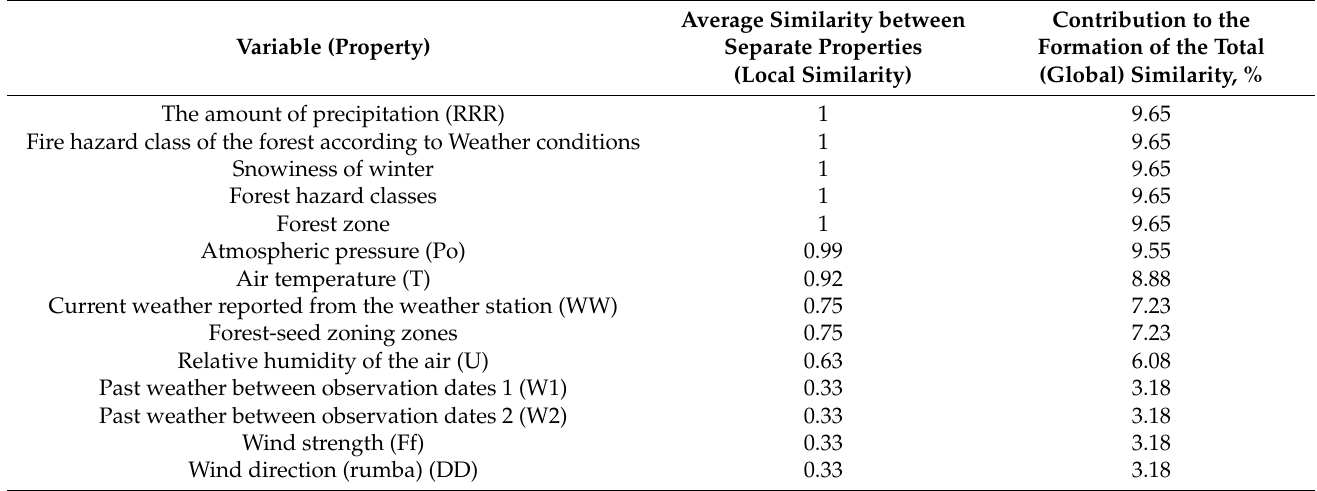
Table 3. The main variables (properties) influencing the formation of the